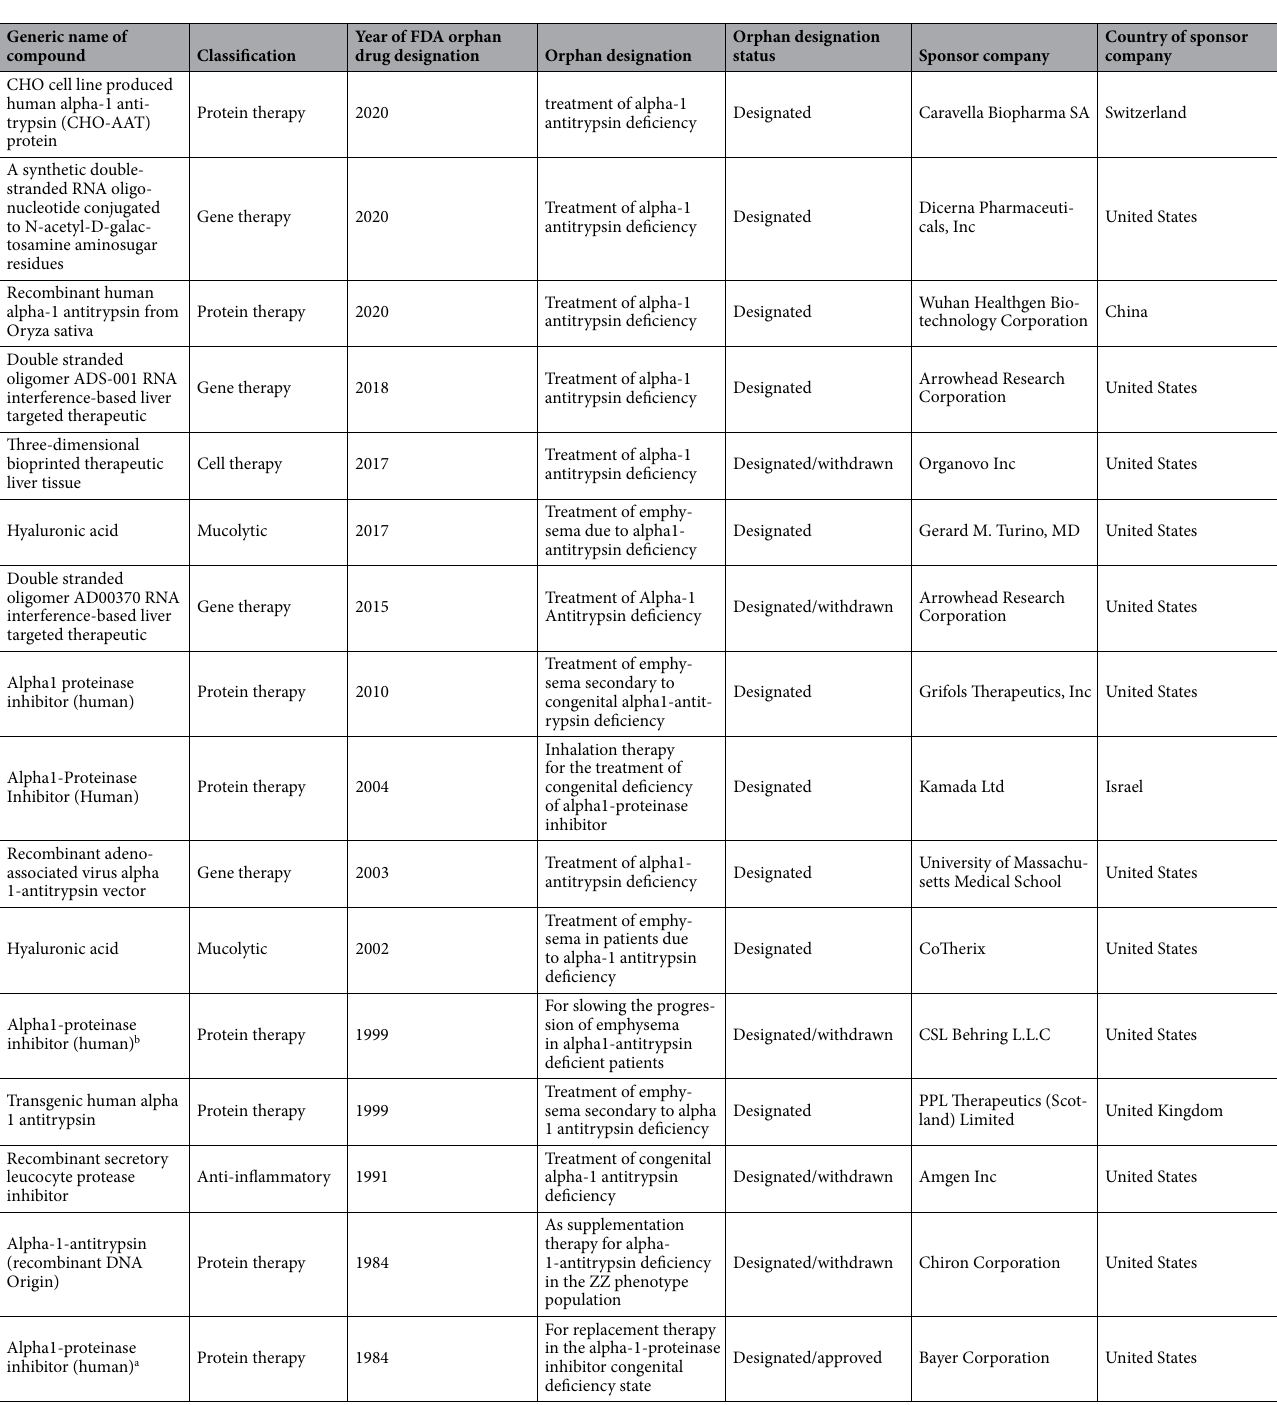
Table 1. FDA orphan drug designations for compounds intended to treat alpha-1-antitypsin deficiency in reverse chronological order sorted by year of orphan drug designation. Close of database: 16 July